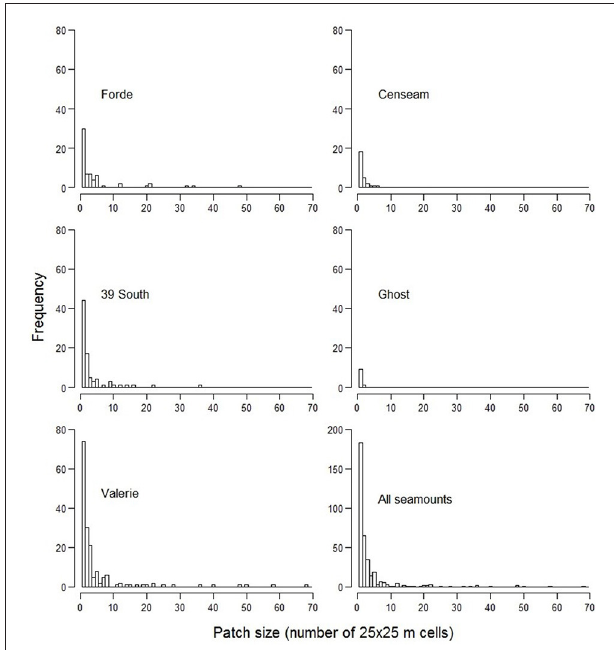
FIGURE 9 | Distribution of predicted VME coral reef habitat patch sizes on individual seamounts and